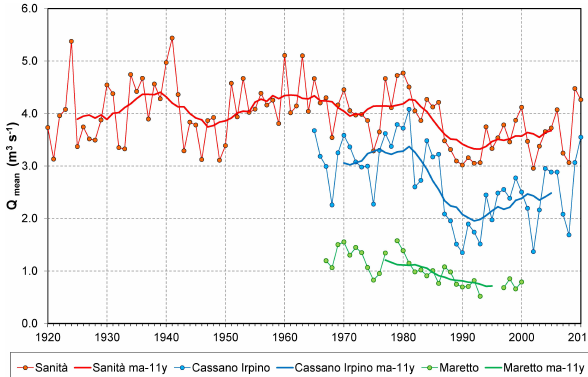
Fig. 9. Graphical comparison of annual mean discharges ( Q mean ) of the Sanit`a, Cassano Irpino and Maretto karst springs (Fig. 1). Key to symbol: continuous thick line=11-yr moving average centred on the sixth